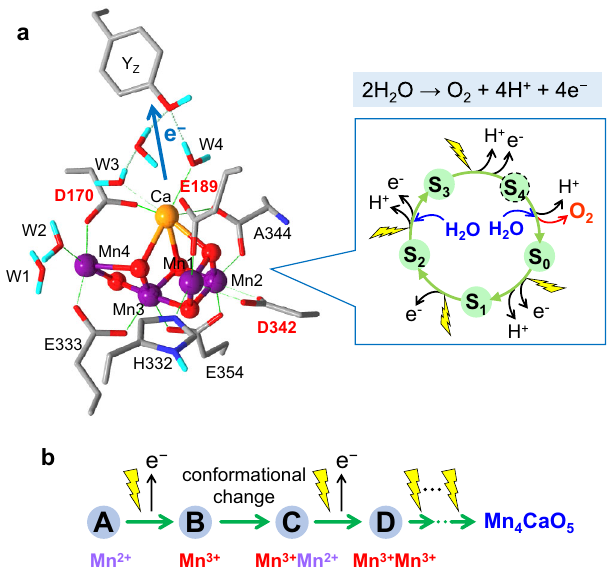
Fig. 1 Structure and reaction of the oxygen-evolving Mn cluster and its photoassembly process. a Structure of the Mn cluster and its ligands, which was obtained by QM/MM calculation based on the X-ray crystallographic structure 6 . Mn, purple; Ca, orange; O, red; N, blue; and H, cyan. The amino acid residues are on the D1 protein except for E354 on the CP43 protein. D1-D170, E189, and D342 are the sites of mutations in this study. The inset shows the S-state cycle of water oxidation. b Early process of the photoassembly of the Mn